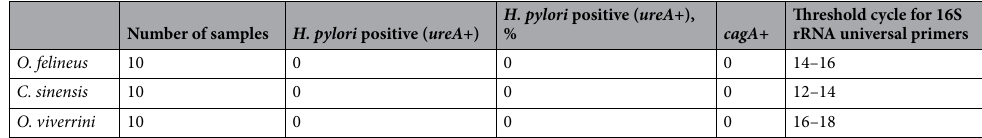
Table 2. Prevalence of H . pylori among the adult liver flukes, as detected by PCR after 45 cycles of amplification with primers targeting H . pylori ureA